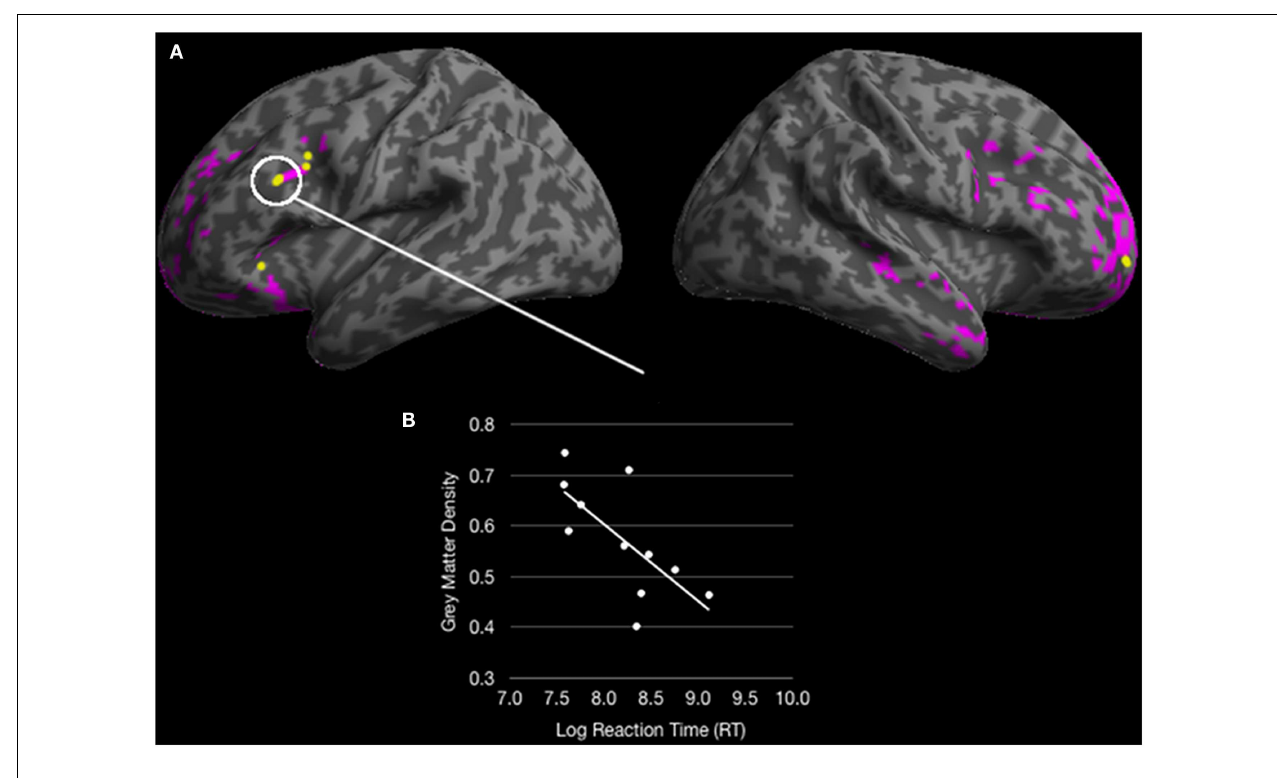
reduced density with fMRI activation for healthy young adults in Experiment 1; (B) A significant correlation between an overlapping region in dorsolateral prefrontal cortex correlates with response times for ambiguous doubly-quantified